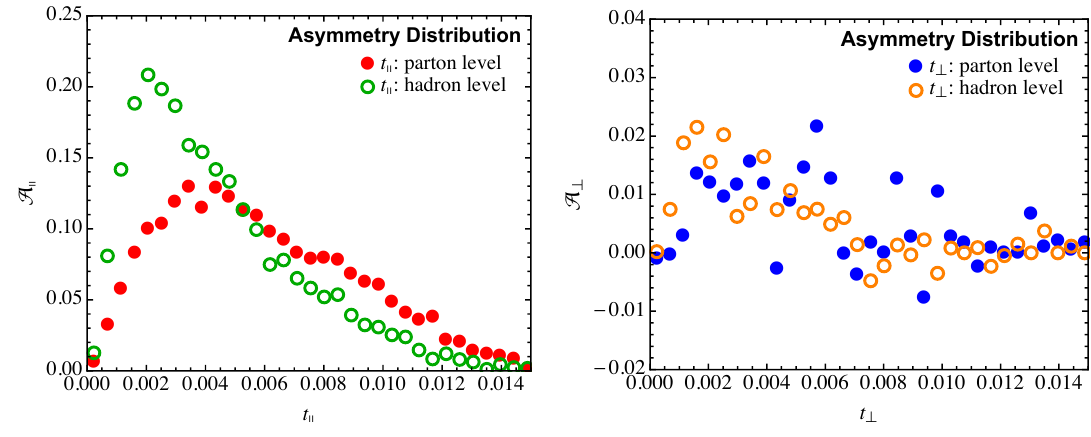
Figure 6 . Monte-Carlo simulations of the A measured on H ! b (cid:22) b events generated with Pythia v8.240. The plots show results at both parton and hadron